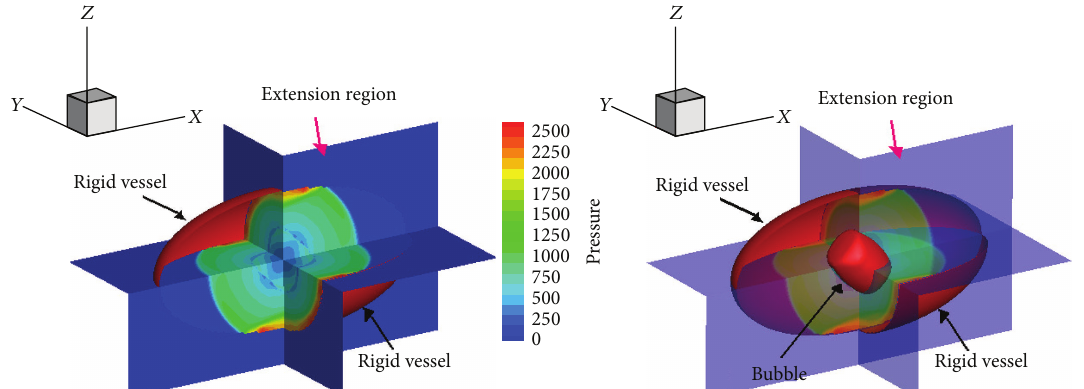
Figure 15: Numerical results by GFM-based algorithm 𝑡 = 0.259 ms. Left: pressure cloud pictures, right: bubble shape (Case